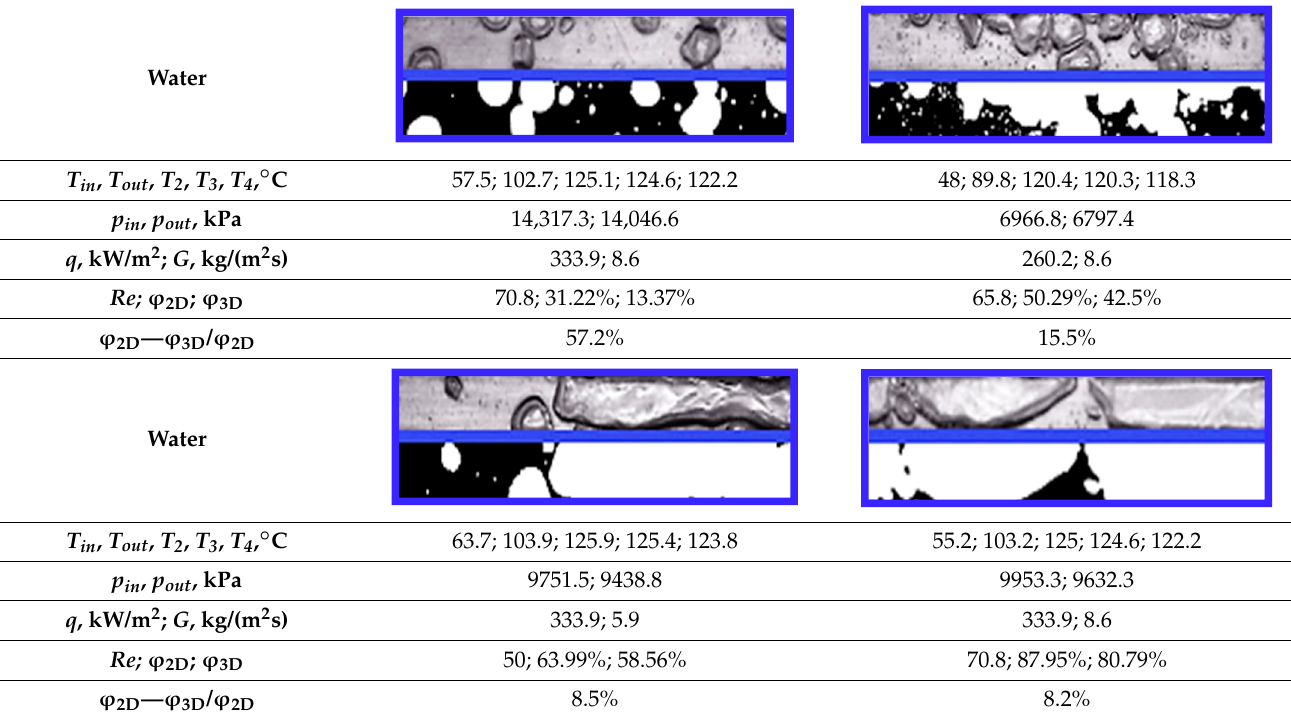
Table 4. Void fraction computed for 2D and 3D approaches.